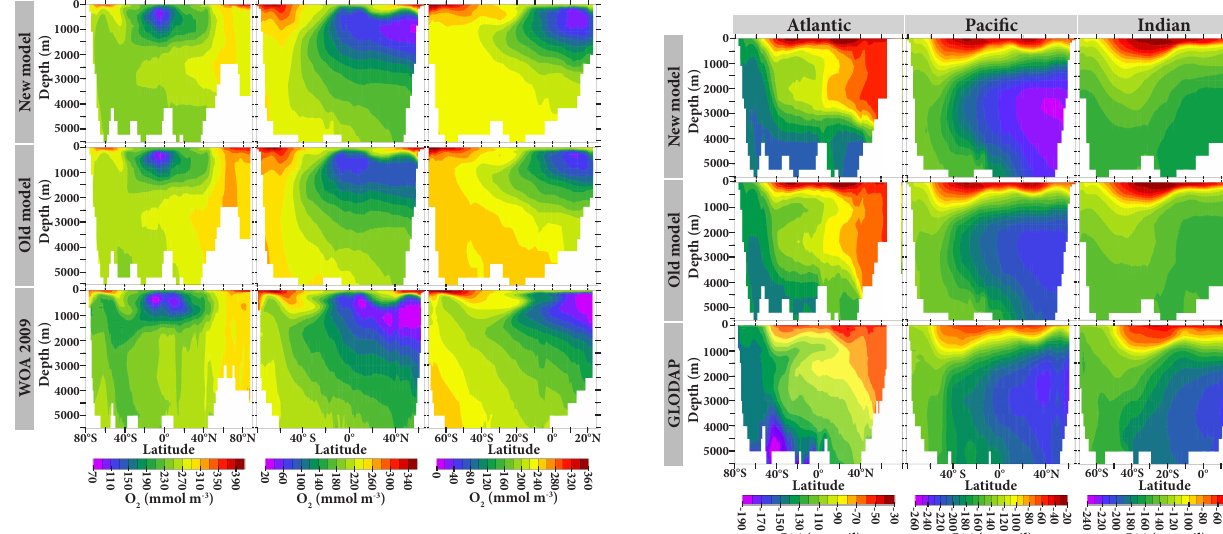
Fig. 6. Zonally averaged ocean basin comparisons of O 2 between the new and old models and the World Ocean Atlas 2009 data set.